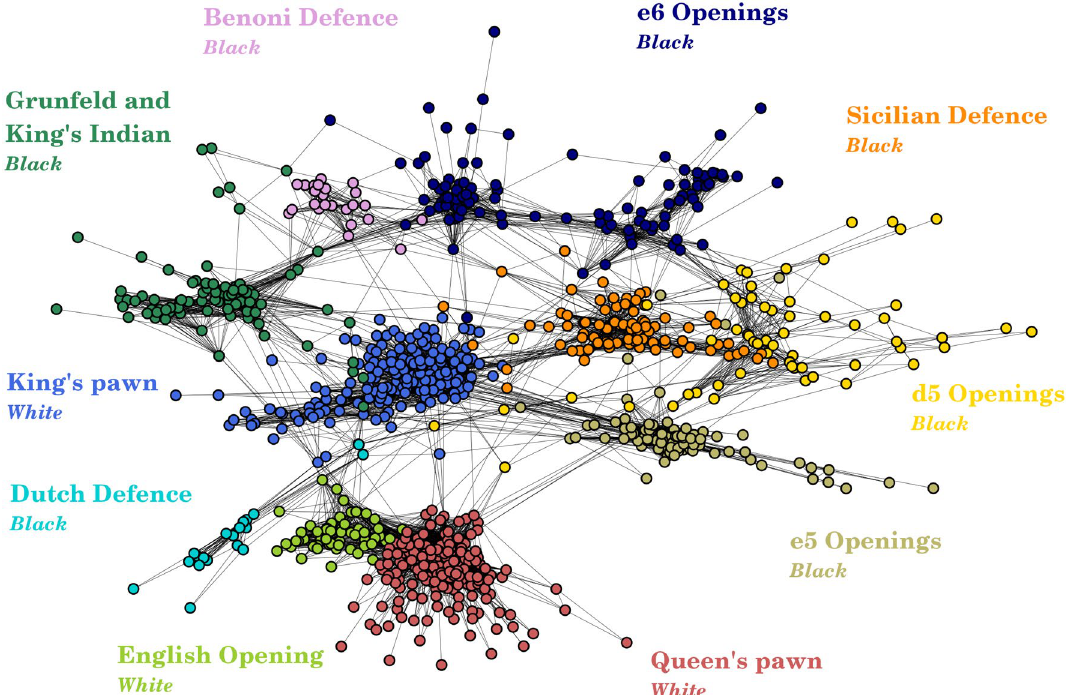
Figure 1. Network of openings. Relatedness network of openings obtained by projecting and validating the player-opening bipartite network. Openings close on this network are similar to play since they often appear together in players’ opening repertoires. Ten clusters identified using the Leiden community detection algorithm are represented in different colors, each cluster corresponding to a different opening